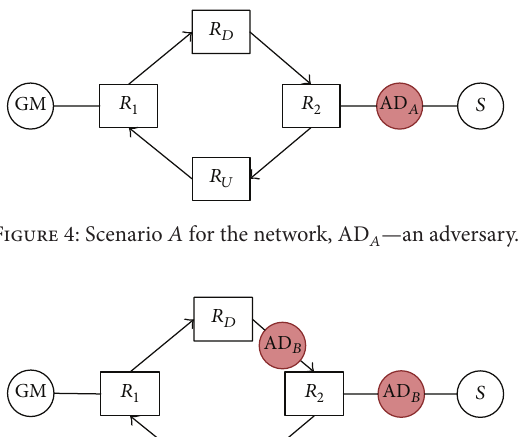
and the router 𝑅 2 and between the router 𝑅 2 and the slave 𝑆